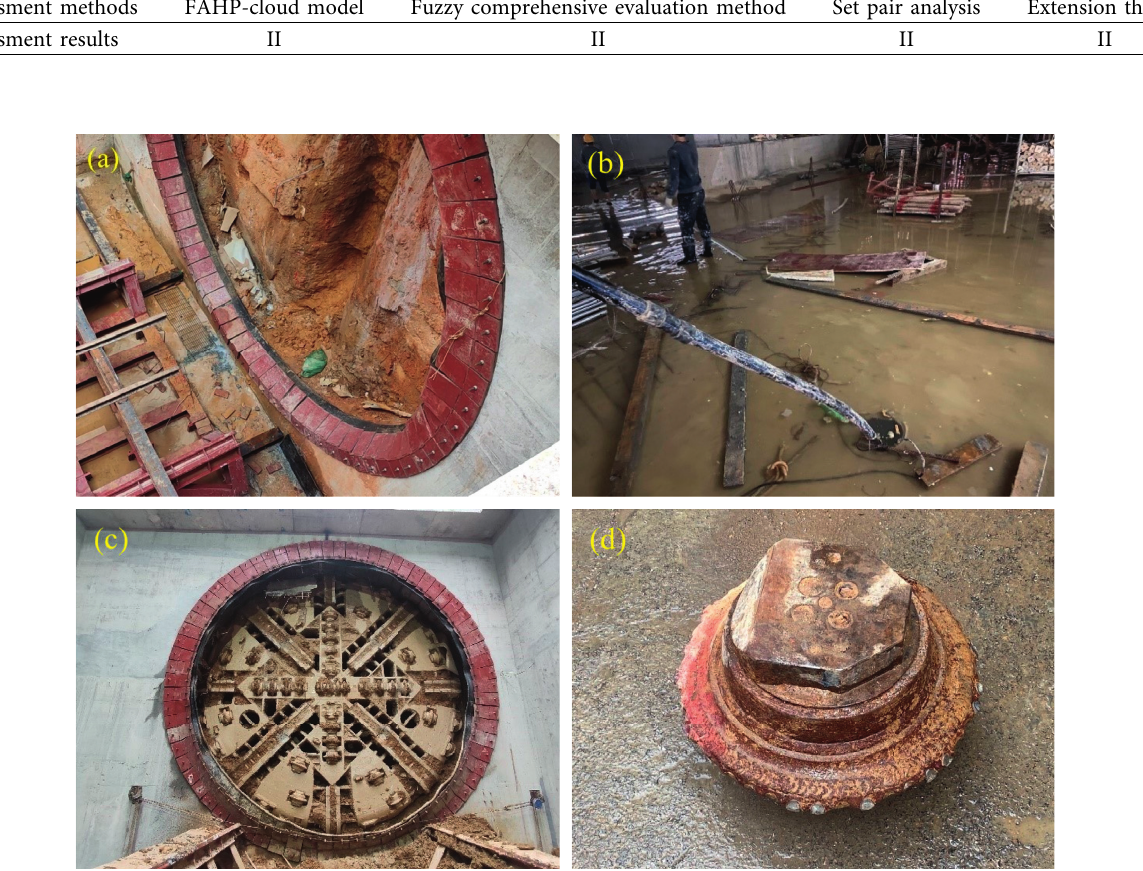
Figure 11: Actual excavation